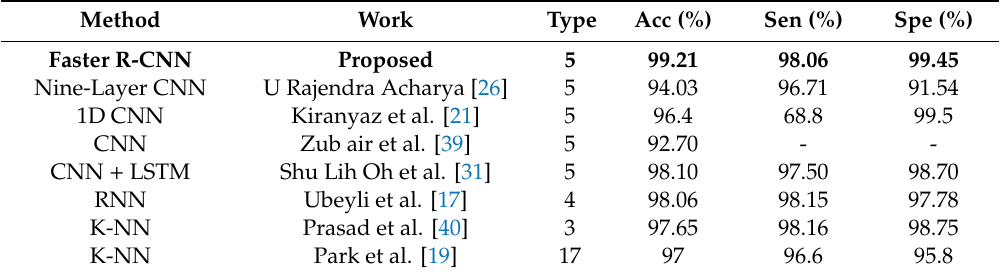
Table 12. Comparison with existing approaches. 1D—one-dimensional; LSTM—long short-term memory; RNN—recurrent neural network; K-NN—K-nearest